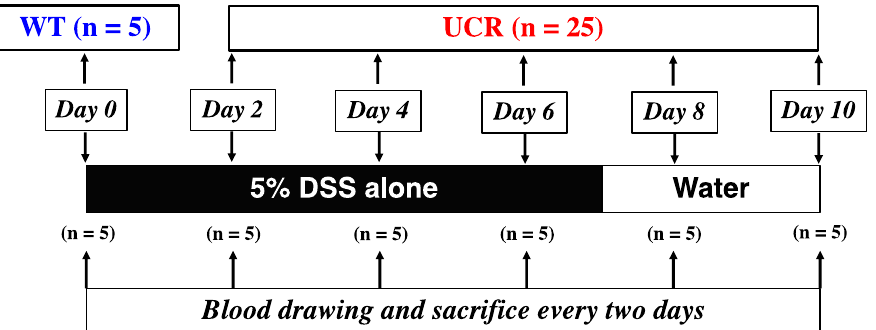
Figure 1. Protocol of animal experiments. WT: normal wild type Slc:Wistar rats (n = 5) were euthanized as negative controls (Day 0). UCR: Slc:Wistar rats were treated with 5% dextran sulfate sodium (DSS) as experimental ulcerative colitis model rats (n = 25). Five rats were euthanized every two days (Days 2–10), and their large intestines and blood were collected.